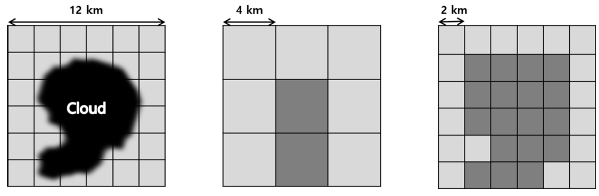
Figure 2. Illustrations of 12km × 12km pixels with different reso- lutions. The dark-grey shading indicates the cloudy pixel, and the light-grey shading indicates the clear-sky pixel. Only 2 cloudy pix- els can be detected with the 4km resolution imagery; in contrast, 18 cloudy pixels can be detected with the 2km resolution imagery. The number of pixels at the cloud boundary varies depending on the resolution (Walker et al.,